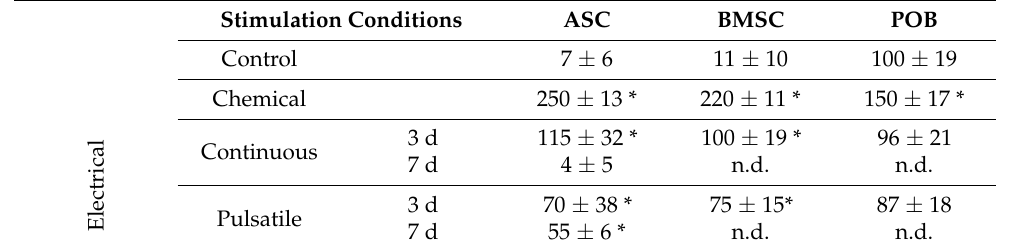
Table 2. summarizes the differences in the impedance values of all measurements between t = 0 and t = 150 h. The values with * were significant different ( p < 0.05) compared to controls. All chemical treatments led to significantly higher impedance in the stem cells (ASC, BMSC), and the primary osteoblasts (POB). The electrical stimulation influenced only the impedance rate of the stem cells. In brief, continuous stimulation over three days increased the impedance to approximately 100 Ω